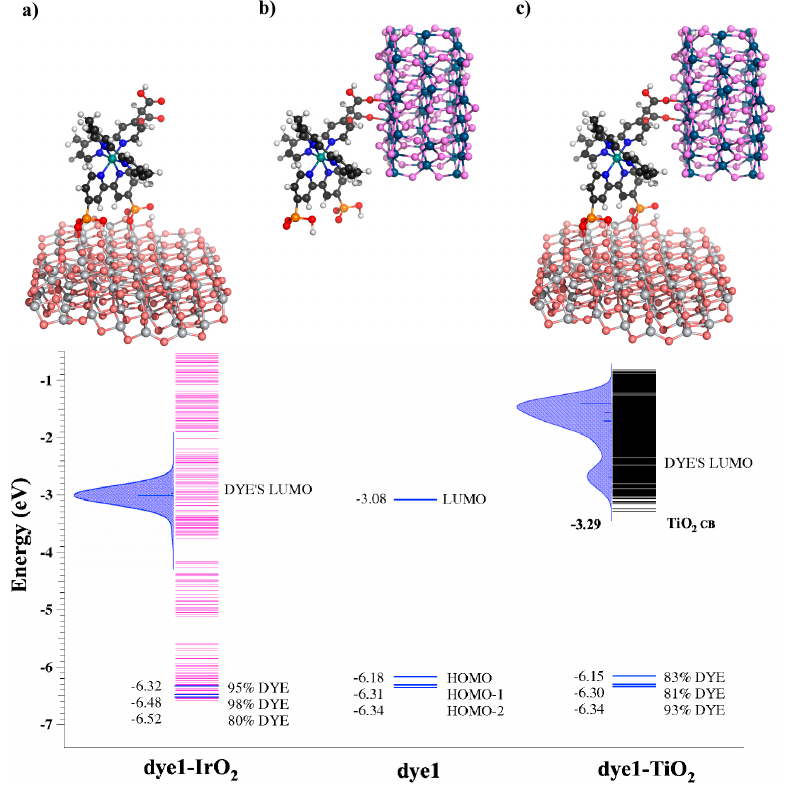
Figure 8. ( top ) Optimized molecular structure of the dye/TiO 2 ( a ); dye/IrO 2 ( b ); and TiO 2 /dye/IrO 2 ( c ) assemblies; ( bottom ) alignment of energy levels for dye1 at TiO 2 /dye and dye/IrO 2 interfaces compared to the energy levels of the stand-alone dye. Dye, IrO 2 and TiO 2 levels are in blue, magenta, and black colors, respectively. The percentages of dye contributions to the HOMOs of TiO 2 /dye and dye/IrO 2 assemblies are also reported. Figure adapted from